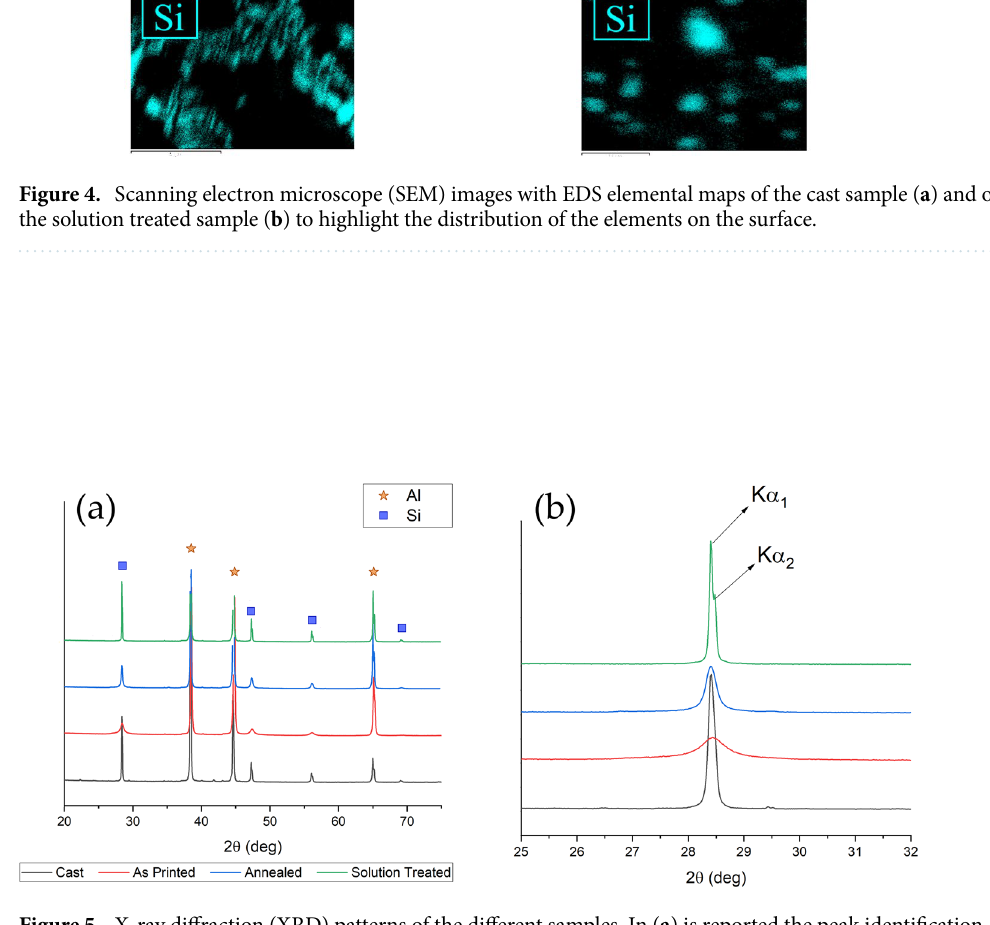
Figure 5. X-ray diffraction (XRD) patterns of the different samples. In ( a ) is reported the peak identification whereas in ( b ) is reported a detail of the first peak of silicon. It can be observed the broadening effect due to the different sizes of the silicon